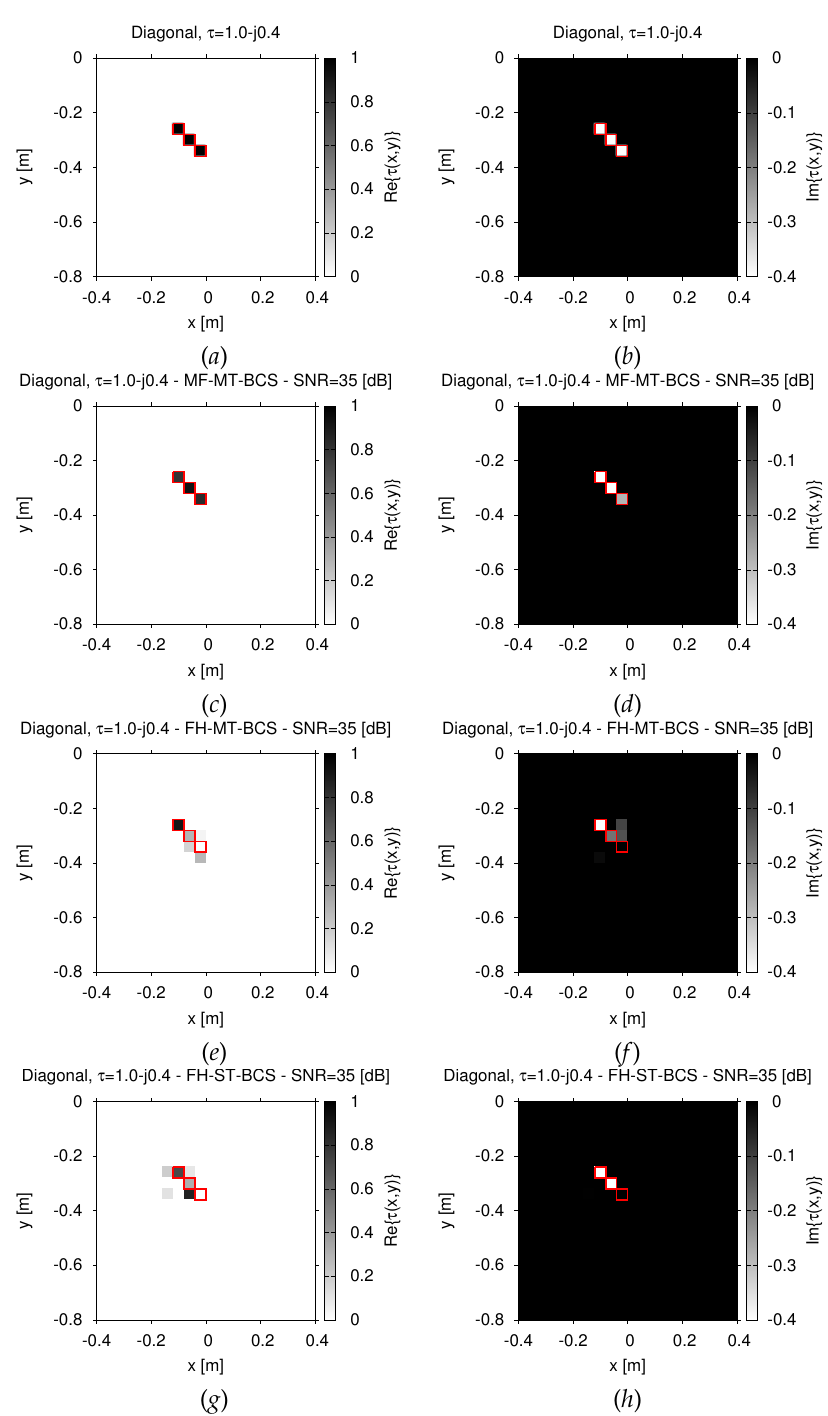
Figure 5. Numerical assessment (“ Diagonal ” Scatterer , τ = 1.0 − j 0.4, N = 400, SNR = 35 dB)—Actual ( a , b ) and retrieved ( c – h ) real part ( a , c , e , g ) and imaginary part ( b , d , f , h ) of the contrast outputted